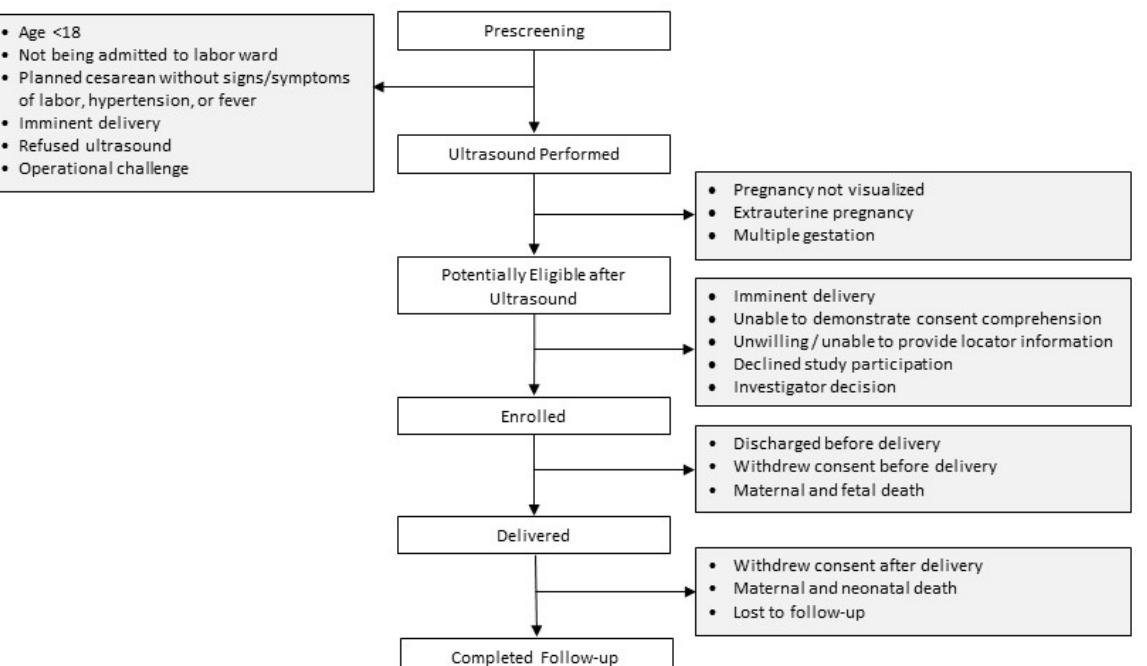
Figure 1. LABOR Study participant flowchart.